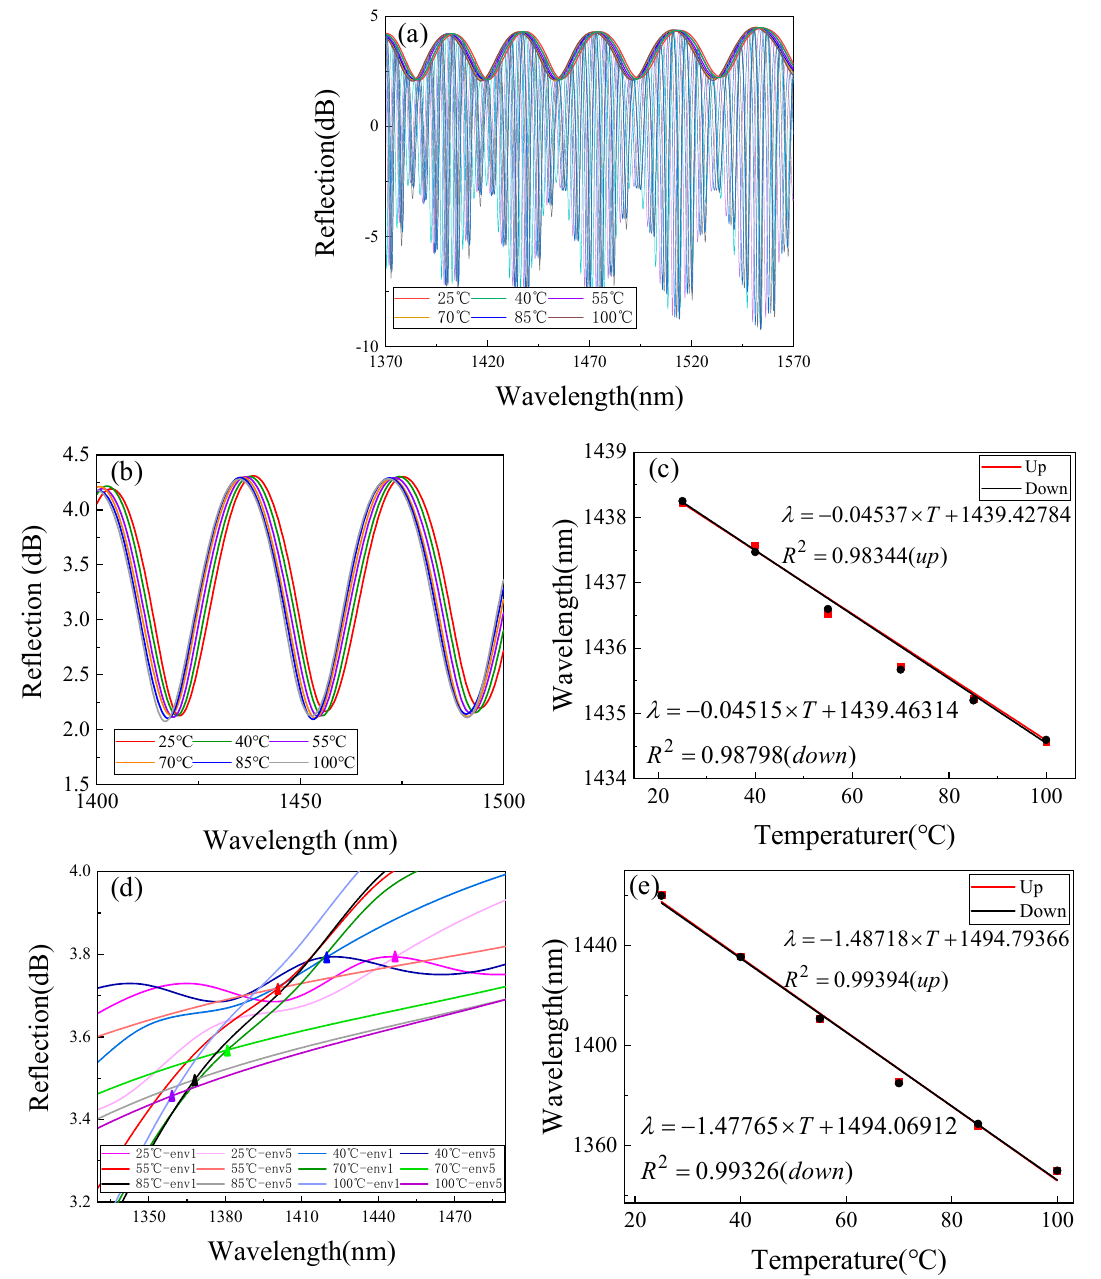
Figure 13. Temperature crosstalk experiment results. ( a ) Temperature response of the sensor; ( b ) spectral variation of the upper envelope; ( c ) the linear relationship between the position of the upper envelope and temperature; ( d ) spectral changes at the intersection of env1 and env5; and ( e ) linear relationship between intersection position and temperature.